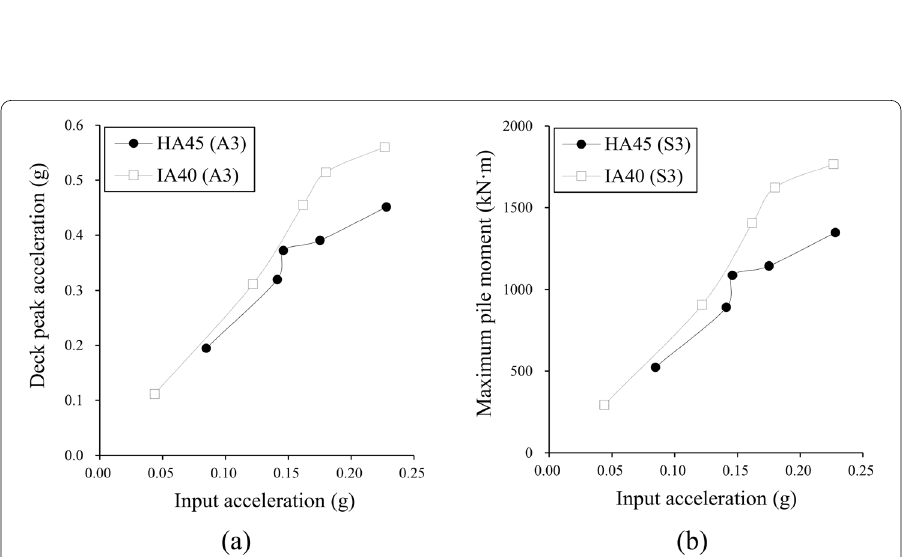
Fig. 9 Comparison of a peak acceleration of deck plate, b maximum pile moment with respect to input acceleration (scaled to the